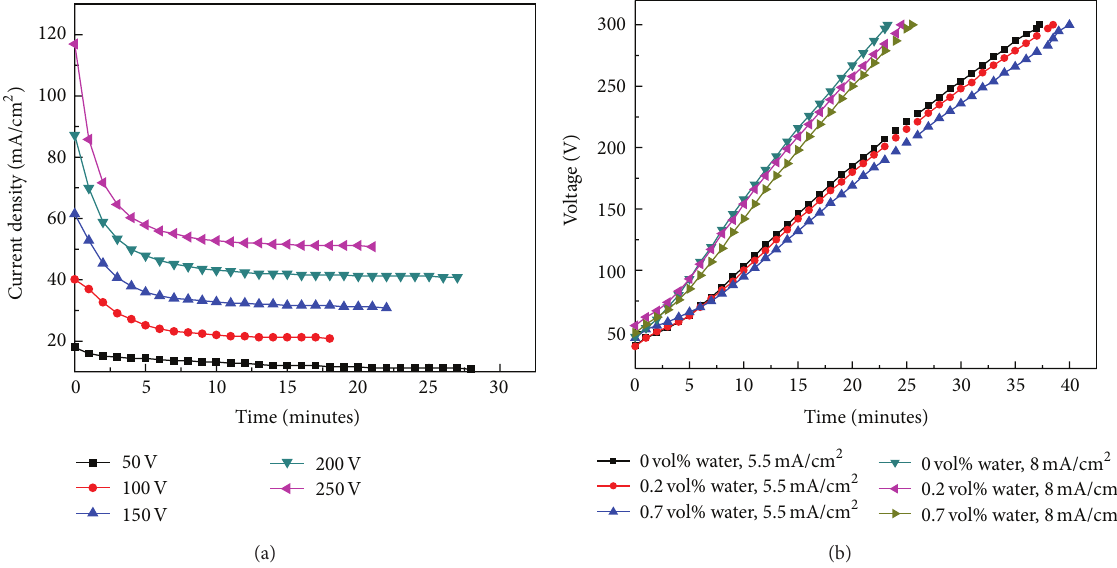
Figure 1: (a) Variation of current density with time in potentiostatic mode at various voltages. (b) Variation of voltage with time in potentiodynamic mode at different current densities and water